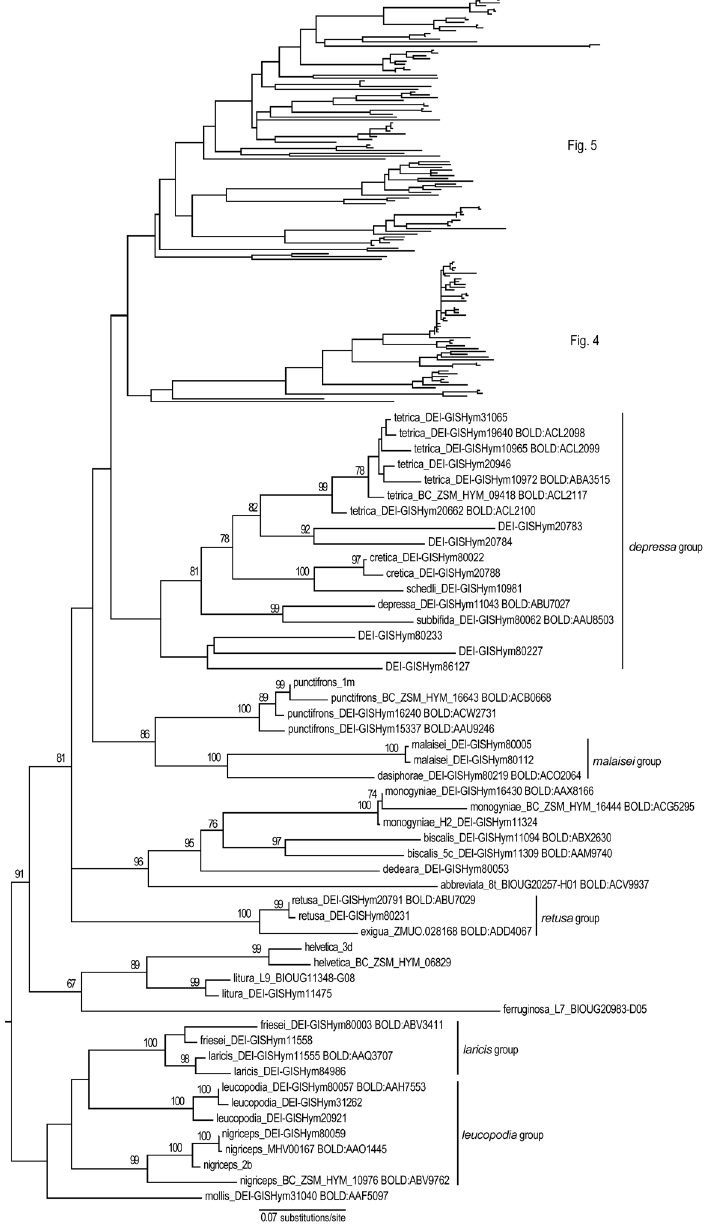
Figure 3. Maximum likelihood tree of Pristiphora based on COI gene (1078 bp). Shortest sequence in- cluded was 462 bp ( subarctica MHV00166). Numbers above branches show bootstrap proportions (%). Support values for weakly supported branches (BP<70) are not shown. BIN numbers (BOLD:XXXXXXX) referred to in the text are shown for representative specimens. Part of Pristiphora is shown without support values and tip labels, which are shown in Figs 4–5. The scale bar shows the number of estimated substitu- tions per nucleotide